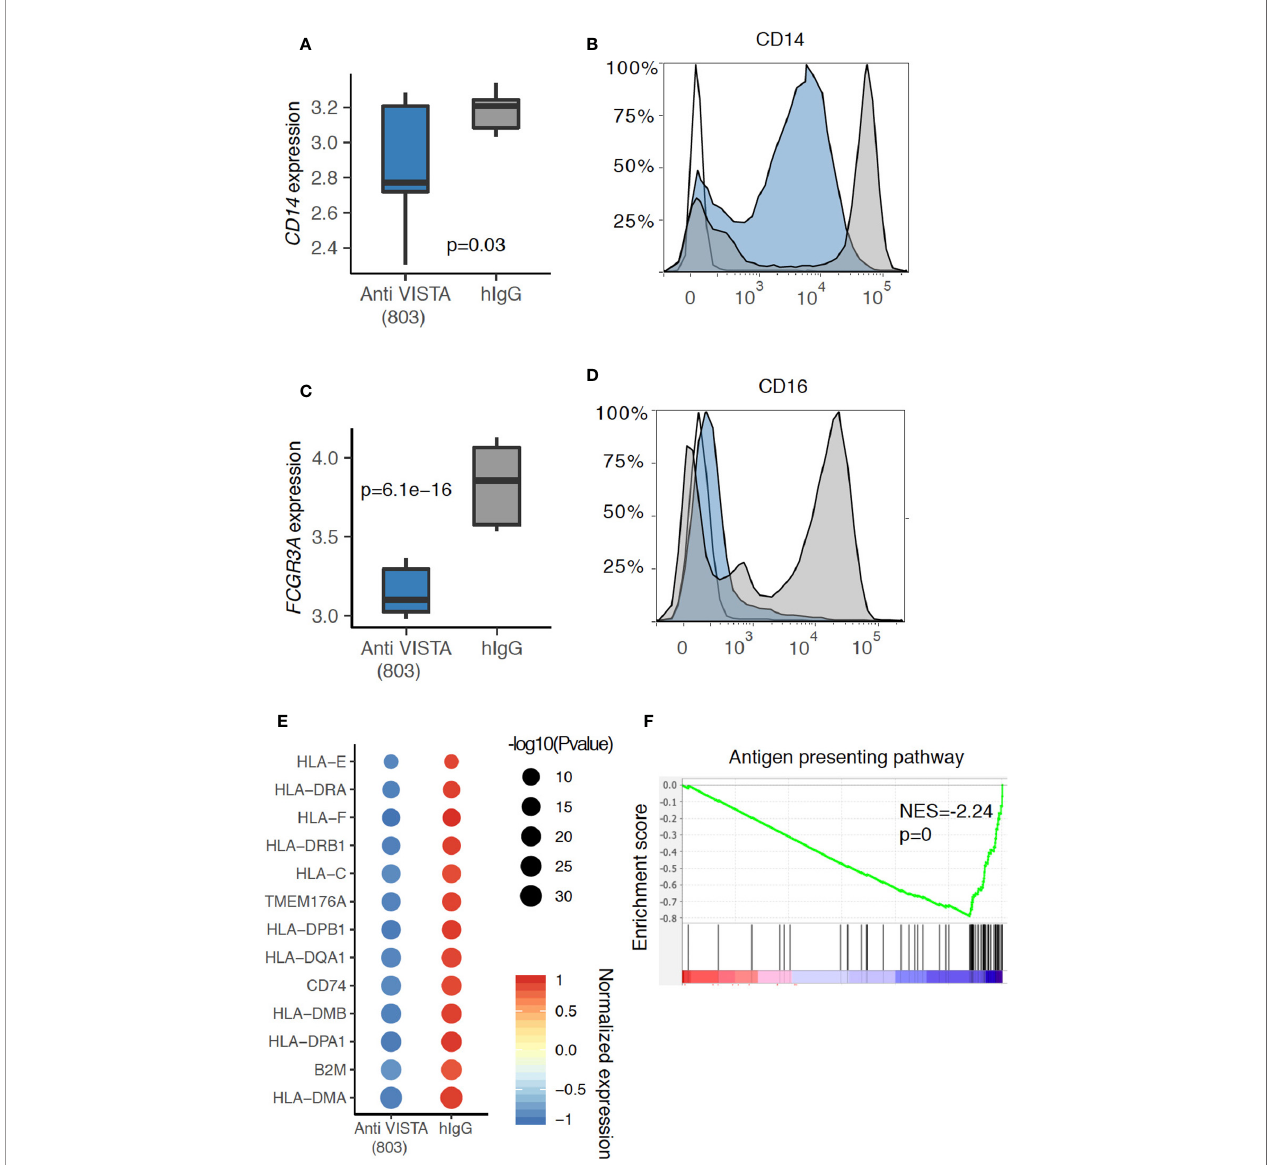
FIGURE 1 | Anti-VISTA agonist suppresses CD14 and CD16 ( Fcgr3a ) expression in human monocytes. (A) Boxplot depicting the CD14 gene expression difference between Anti-VISTA (803) and hIgG2 isotype control treated CD14+ human monocytes. (B) Flow cytometry plot showing the CD14 protein expression between Anti- VISTA (803) and hIgG2 isotype control treated CD14 + human monocytes. (C) Boxplot depicting the Fcgr3a gene expression difference between Anti-VISTA (803) and hIgG2 treated CD14+ human monocytes. (D) Flow cytometry plot showing the CD16 protein expression between Anti-VISTA (803) and hIgG2 treated CD14+ human monocytes. Flow cytometry experiments are representative of three independent experiments with one donor per each experiment. (E) Dot plot showing the antigen presenting associated genes difference between Anti-VISTA (803) and hIgG2 isotype control treated CD14+ human monocytes. (F) GSEA plot showing the enrichment of antigen presenting pathway between Anti-VISTA (803) and hIgG2 treated CD14+ human monocytes. RNA-seq experiments are representative of three independent repeats on three healthy